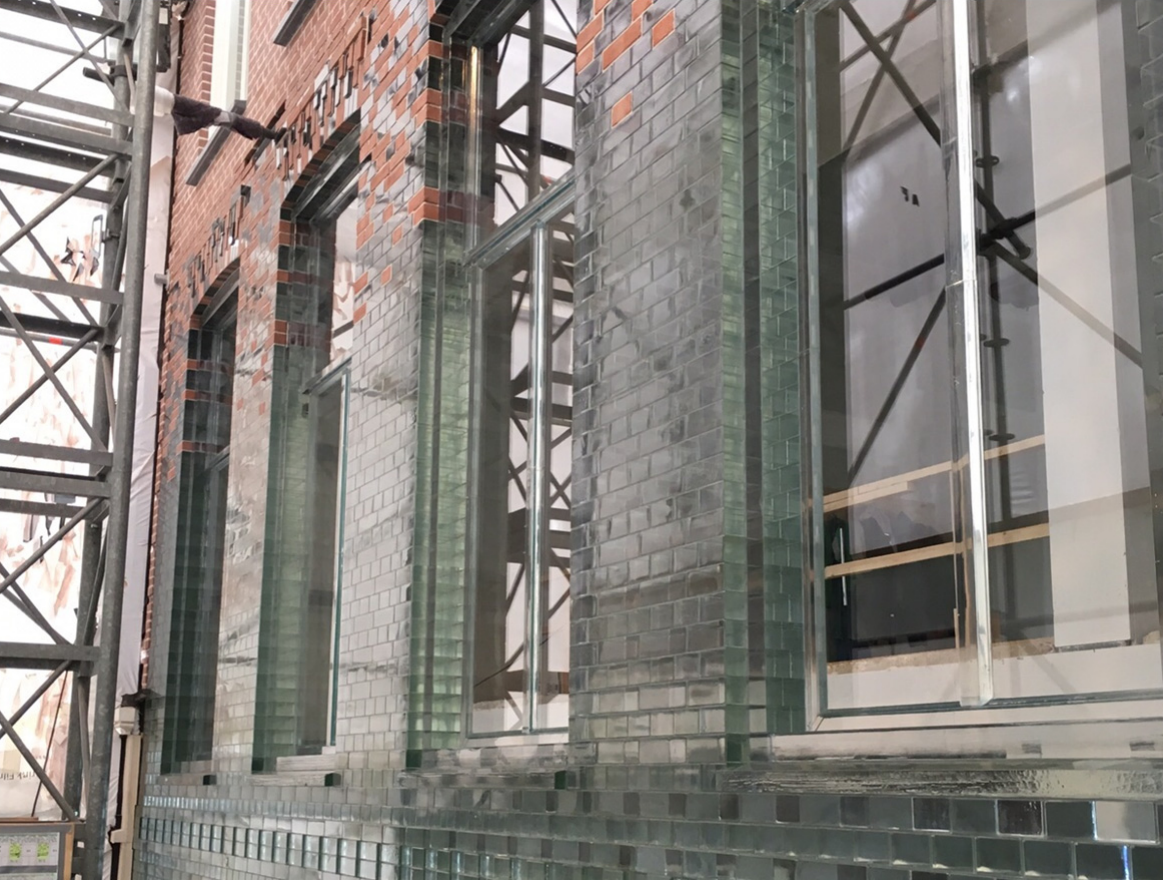
Fig. 10 The façade after the bonding and sealing of the ceramic